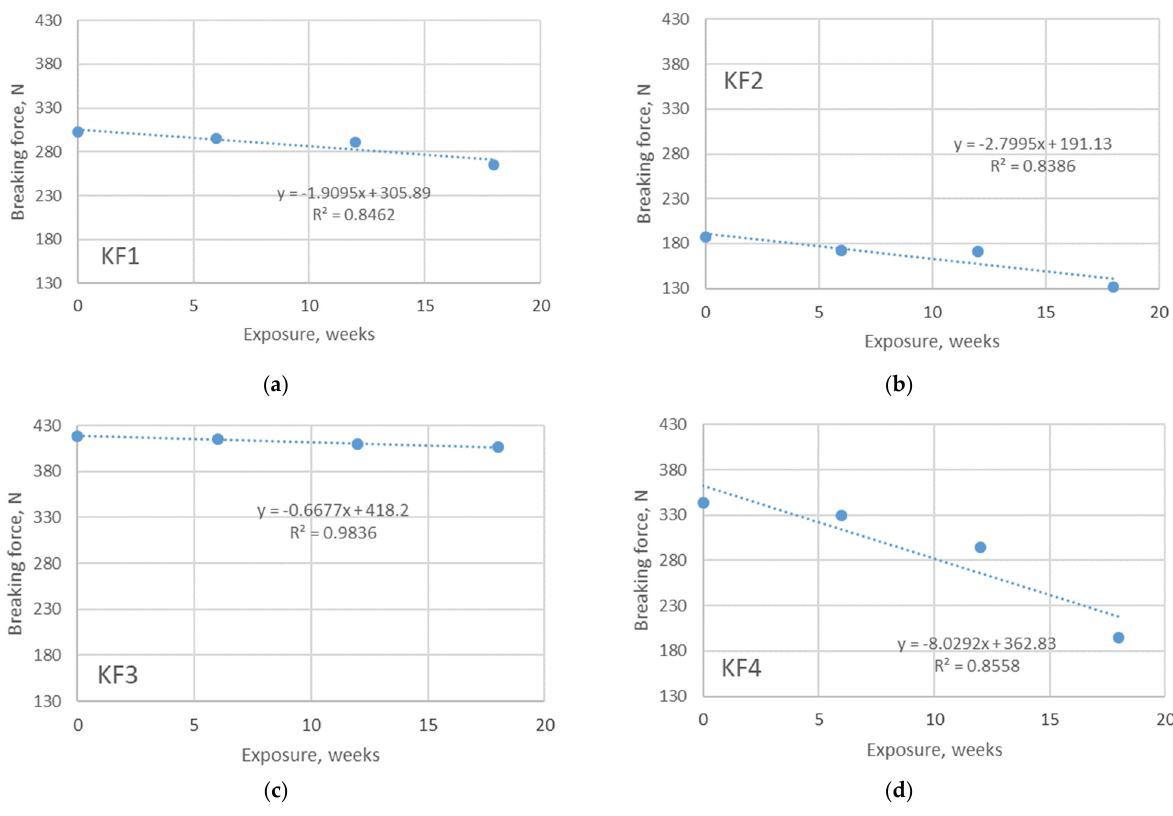
Figure 5. Breaking force of materials exposed to aging in pool water, outdoors. The overview is given for: ( a ) material KF1; ( b ) material KF2; ( c ) material KF3; ( d ) material KF4.